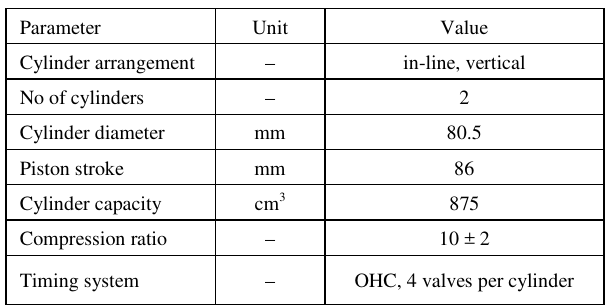
Table 1. Technical data of the Fiat 0.9 TwinAir engine [1]